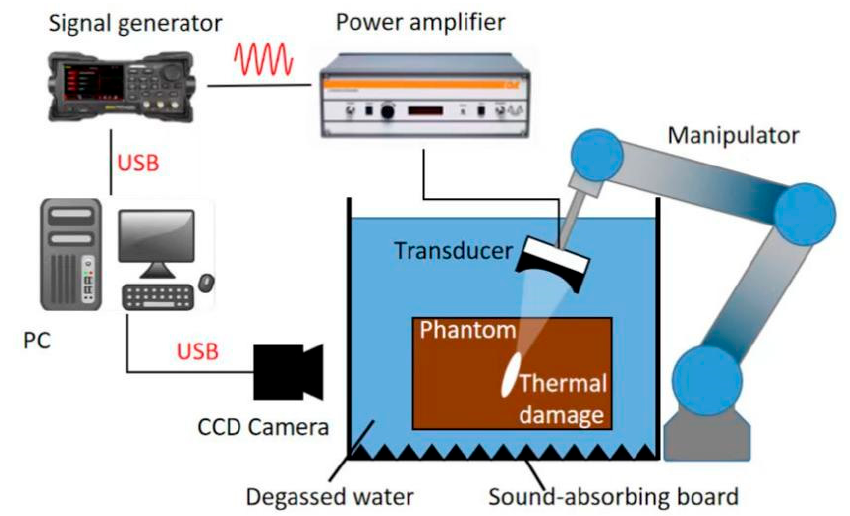
Figure 2. Schematic diagram of the experimental system. The arbitrary signal generator (DG5072, RIGOL, Beijing, China) was used to generate the excitation signal, the parameters of the transducer used in the experimental system were consistent with the simulation, the curvature radius of the transducer was 150 mm, and the aperture diameter was 95 mm. The excitation signal was a sine wave with a center frequency of 1.12 MHz, and HIFU was applied in 200-ms pulses with a 200-ms pulsing interval (i.e., 50% duty cycle), such that the signal passed through the power amplifier (AR800W, Amplifier Research, Souderton, PA, USA) and drove the transducer to irradiate the ultrasonic wave. In the phantom experiment, the camera (30 fps) could accurately monitor the BFR due to the transparency of the phantom. The phantom was placed at the focus of the focused transducer in water, and the signal generated by the signal source was excited by the power amplifier. The camera was used to record the variations in the BFRs of the phantom during HIFU ablation.